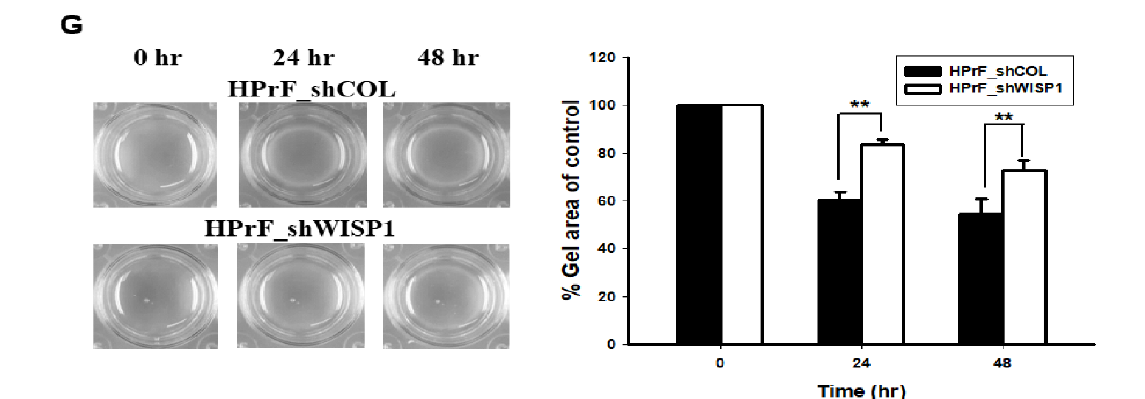
Figure 1. Modulating effect of WISP1 on the cell proliferation and contraction in prostate fibroblast HPrF cells. ( A ) Expression of WISP1 in prostate cells was determined by a RT-qPCR. ( B ) Two WISP1 isoforms (WISP1v1 and WISP1v2) were found in the human prostate fibroblast HPrF cells by RT-PCR with the pair of primers as shown. The secretion of WISP1 ( C ) and mRNA levels of WISP1v1 and WISP1v2 ( D ) after WISP1 was knock-downed in the HPrF cells (M: 100 bp Marker; 1: HPrF_shCOL; 2: HPrF_shWISP1). ( E ) Gene profile of human prostate fibroblast HPrF cells after WISP1 was knock- downed. Cell proliferation ( F ) and contraction ( G ) of the mock-knock-down HPrP (HPrF_shCOL) and the WISP1-knock-down HPrF (HPrF_shWISP1) cells were measured by the EdU proliferation and collage contraction assays, respectively. Data are presented as the mean percentage ( ± SE; n = 3) of the HPrF_shWISP1 cells in relation to the HPrF_shCOL cells. * p < 0.05; ** p < 0.01; ND: no detectable.